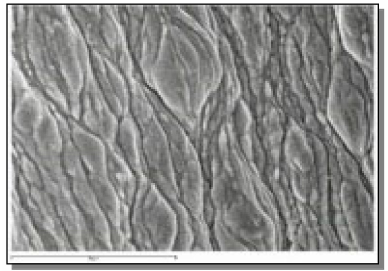
Figure 9. Hypotube #8(ref): structure of the interior surface (scale = 20 µ m). Hypotube #6 presented a longitudinal defect (Figure 10)—due not to corrosion but instead to a tearing off, probably a consequence of the stretching process.